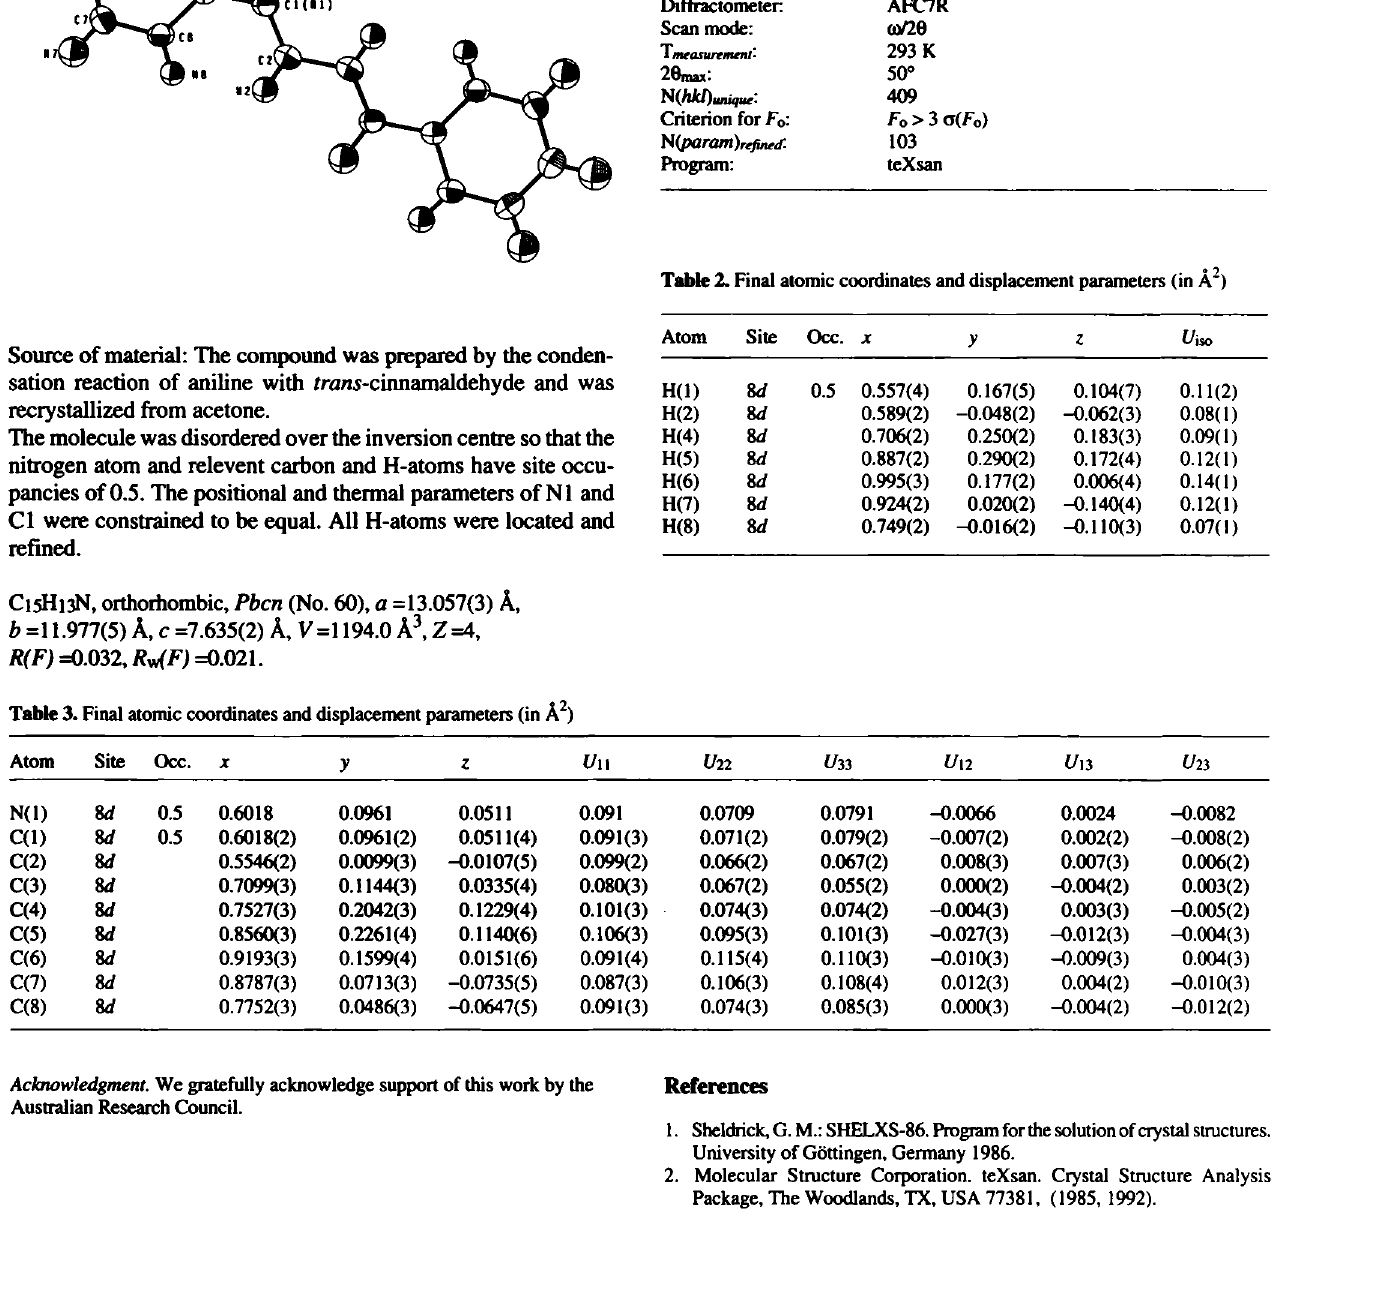
Table 1. Parameters used for the X-ray data collection Crystal: